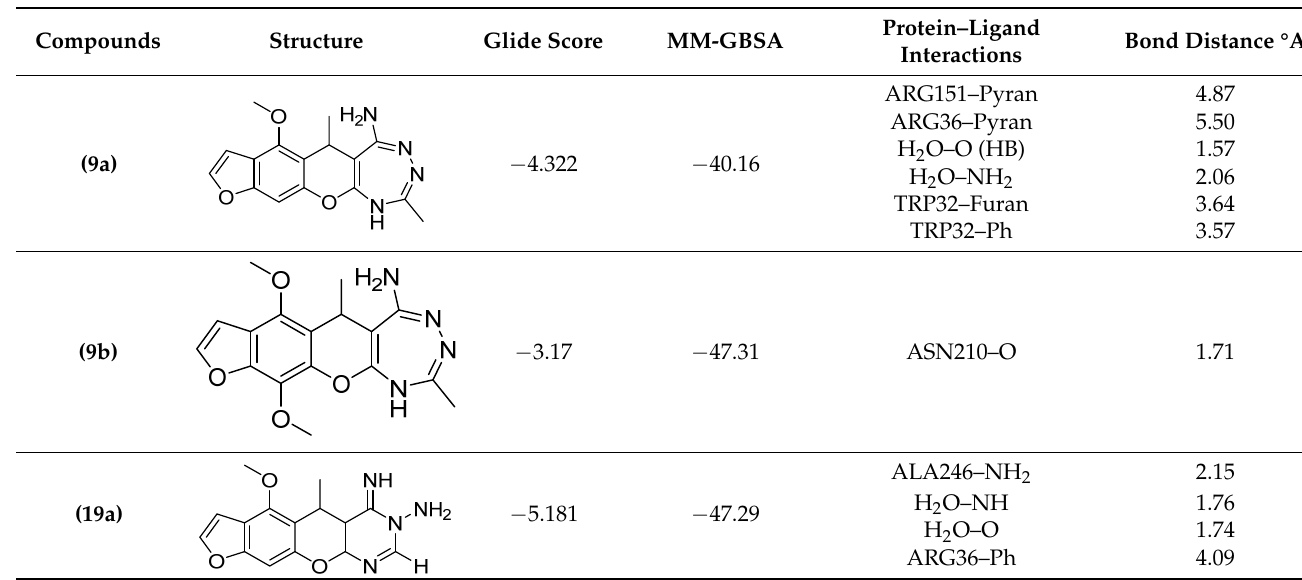
Table 3. Glide score, glide energy, binding energies (MM/GBSA), and interaction of the synthesized molecules with amino acid residues of 1HNJ protein.